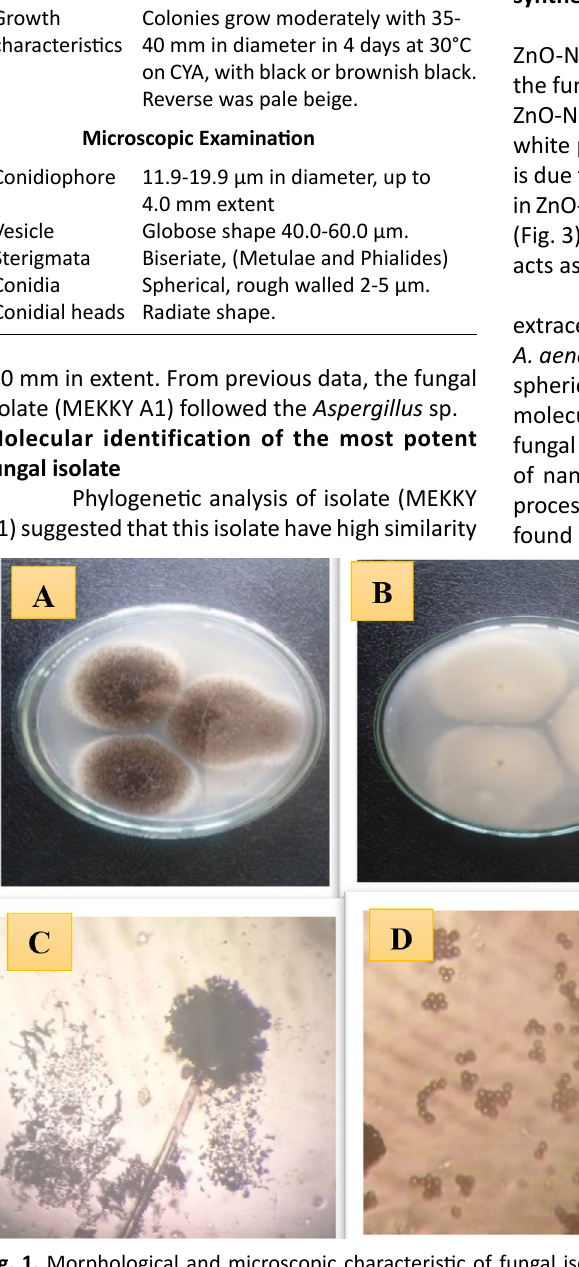
Fig. 1. Morphological and microscopic characteristic of fungal isolate (MEKKY A1) Aspergillus sp. (A) colony of fungal isolate Aspergillus sp. on CYA, (B) reverse colony of fungal isolate Aspergillus sp., (C and D), bright field microscope (X= 20×40